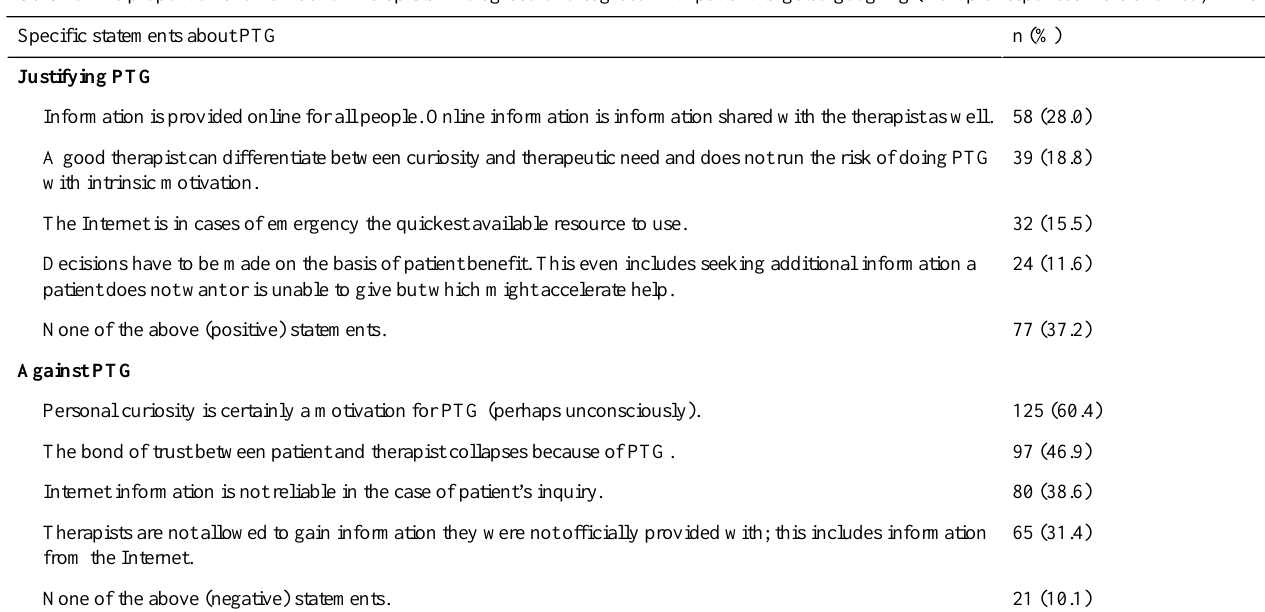
n (%)Specific statements about PTG